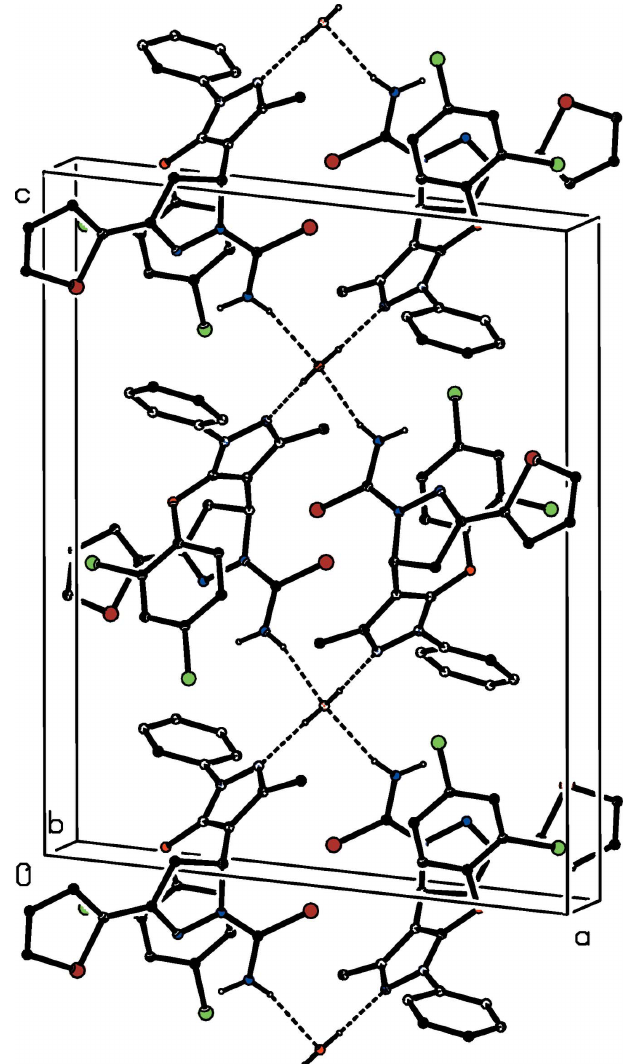
Figure 7 Part of the crystal structure of compound (Ib) showing the formation of a hydrogen-bonded chain of spiro-fused rings running parallel to the [001] direction. Hydrogen bonds are drawn as dashed lines and, for the sake of clarity, the H atoms which are bonded to C atoms have been